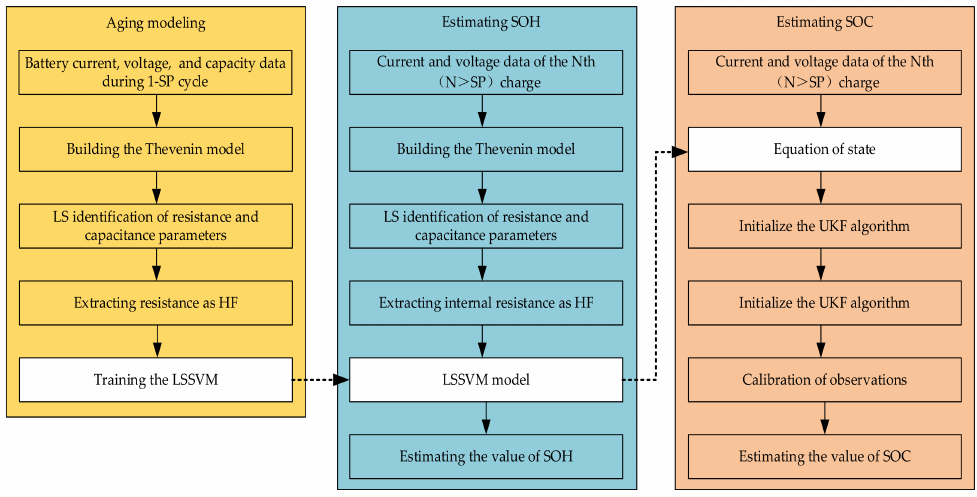
Figure 16. Block diagram of joint SOC/SOH